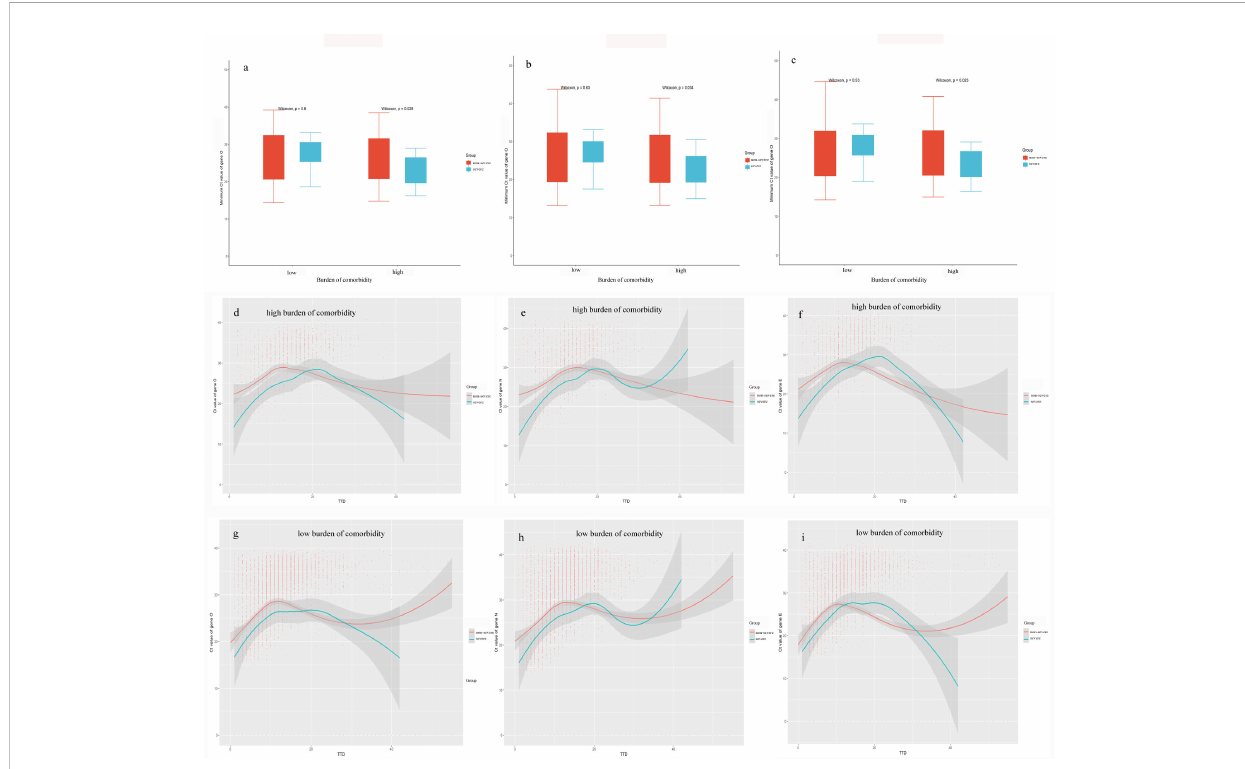
FIGURE 2 Kinetic changes of Ct values according to disease severity. (A – C) : Distributions between disease severity and Ct values for target genes in high and low comorbidity burden subgroups. (C – E) : Kinetic changes of Ct values for target genes in patients with a high burden of comorbidity from severe and non-severe groups. (F – I) : Kinetic changes of Ct values for target genes in patients with a low burden of comorbidity from severe and non- severe groups. The blue and red lines showed the trend in viral loads of severe and non-severe groups, respectively, using curve fi t with non-linear regression with 95% con fi dence intervals (shaded color) from the regression line. TTD: Times to detection of nucleic acid